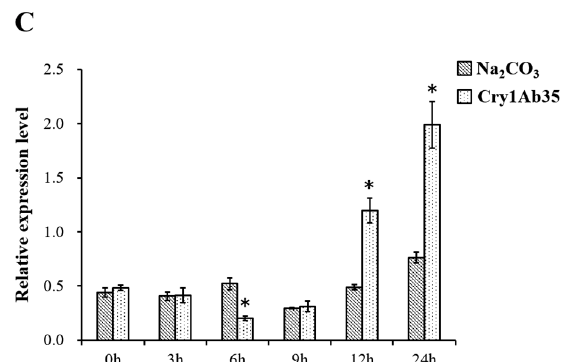
Figure 7. Expression profiles of HcAPN3 in different larval tissues ( A ); in different developmental stages ( B ) and induced by Cry1Ab35 toxin ( C ). Tissue and temporal expression of HcAPN3 were analyzed by semi-quantitative PCR. Tissues were isolated from fifth instar larvae including the foregut, midgut, hindgut, fat body, Malpighian tubules, and epidermis. Larval developmental stages include the first to sixth instars and pupae. Induced expression profile of HcAPN3 with dietary Cry1Ab35 toxin was measured by qPCR. Larvae fed 50 mM Na 2 CO 3 (pH 10.0) were used as the negative control. RNA of midgut tissues was extracted at 0, 3, 6, 9, 12, and 24 h after treatment. The housekeeping gene HcActin was shown as the internal control and the experiments were performed in three biological replicates. The mean ± standard errors ( ± SEM) was calculated to measure the relative expression levels by the 2 − ∆∆ C t method. Statistically significant differences from control samples are indicated by asterisks ( p < 0.05, SNK test).